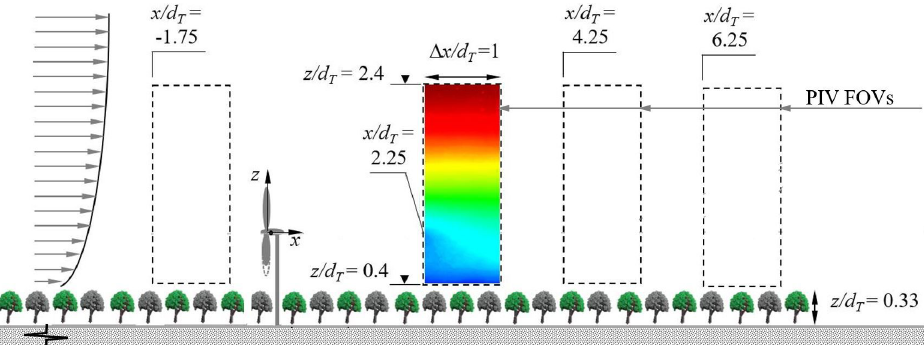
Figure 3. Basic schematic of the experimental setup illustrating two forest models with different tree density, PIV fields of view (FOVs), and basic dimensions.